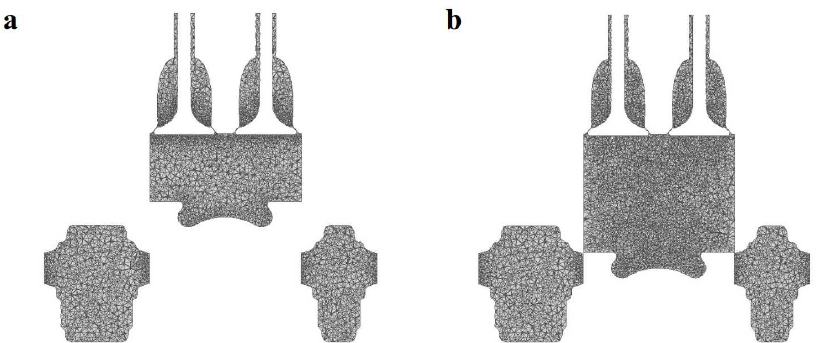
Figure 5. Dynamic remeshing of the computational grid. Computational mesh along a crossing plane through the exhaust valves axes at 74 ◦ ( a ) and 246 ◦ ( b ) CA.